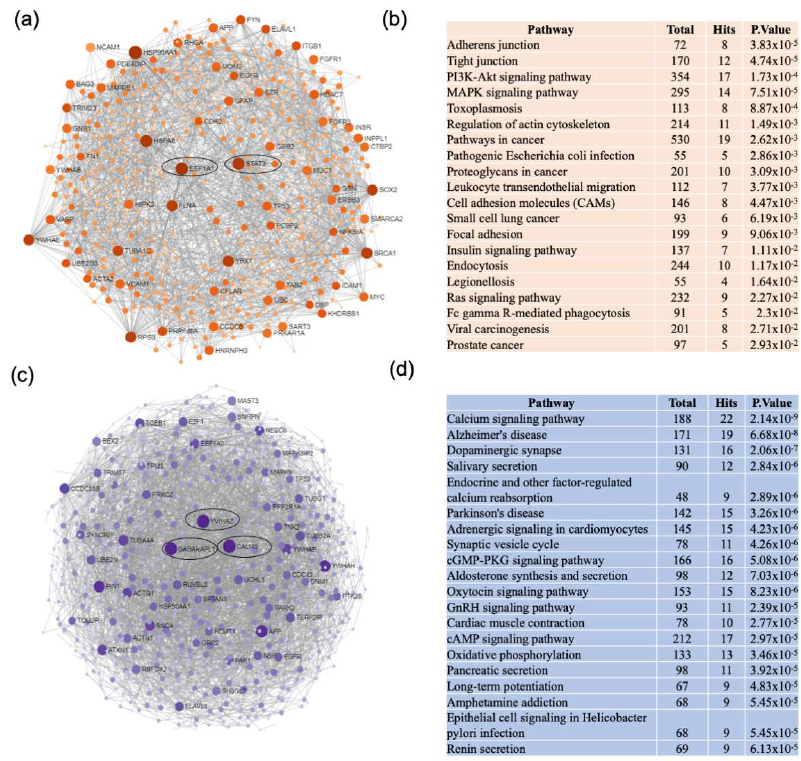
Figure 3. Network and pathway analyses of dysregulated genes in the frontal cortex of AD patients. Integrative meta-analysis was performed on datasets from AD patients compared to non-demented controls to identify unique dysregulated pathways in the frontal cortex of AD. Network and pathway analyses were performed using NetworkAnalyst. Tissue specific networks derived from the protein-protein interaction database from brain frontal cortex were selected. The minimum connected network was analyzed further. Results from the pathway analysis are derived from the Kyoto Encyclopedia of Genes and Genome (KEGG). ( a ) Upregulated genes are shown in orange. Most significant hubs according to degree and betweenness centrality, with the highest number of connections, are enclosed in ovals. ( b ) The 20 top dysregulated pathways ranked according the p-value of significance are presented in the table. Totals refers to the total number of genes that are known to be involved in the KEGG pathway and hits refers to the number of genes identified in this analysis that are involved in the pathway. ( c ) Downregulated genes are shown in blue. Most significant hubs according to degree and betweenness centrality, with the highest number of connections, are enclosed in ovals. ( d ) The 20 top dysregulated pathways ranked according the p-value of significance are presented in the table.